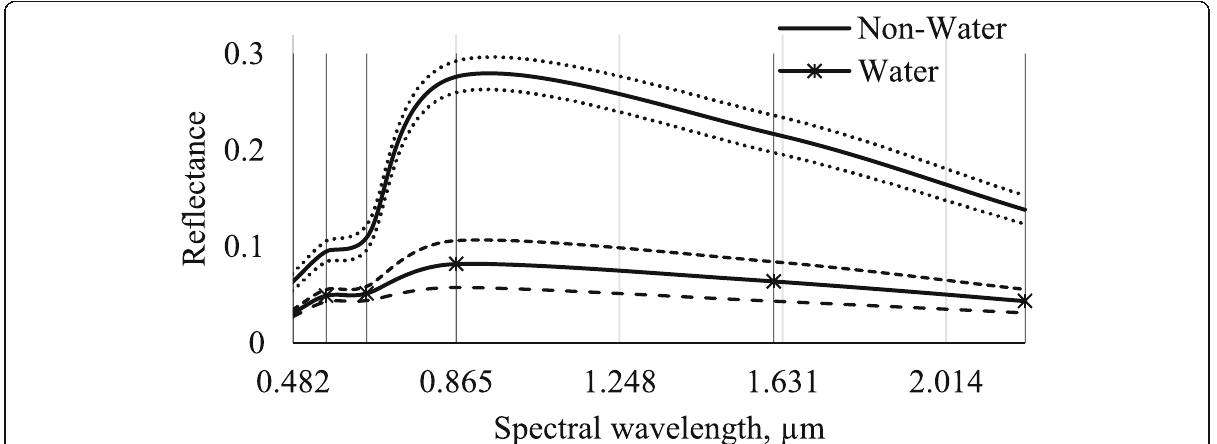
Fig. 4 Spectral signature plot of water and non-water bodies. Verticals lines are central values of spectral ranges of bands 2 to 7 from left to right. Dashed ( − − − ) and dotted ( ··· ) lines represent the 95% confidence intervals of water and non-water bodies,